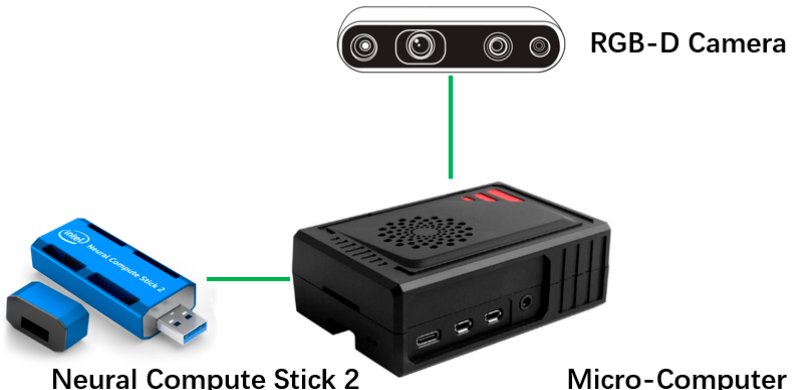
Figure 3. Portable computing terminal .